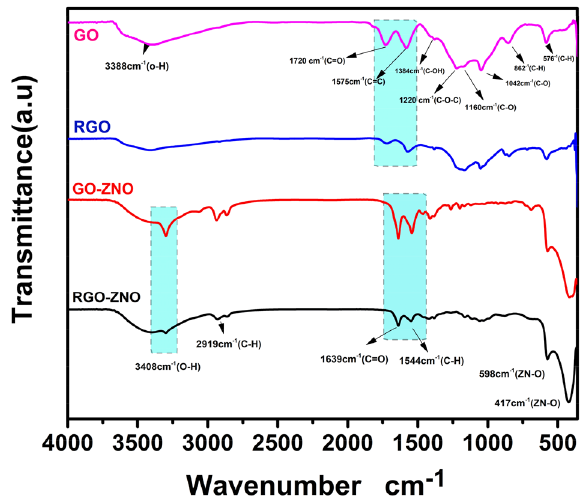
Figure 3. FTIR spectra of GO, RGO, GO-ZnO, and RGO-ZnO.